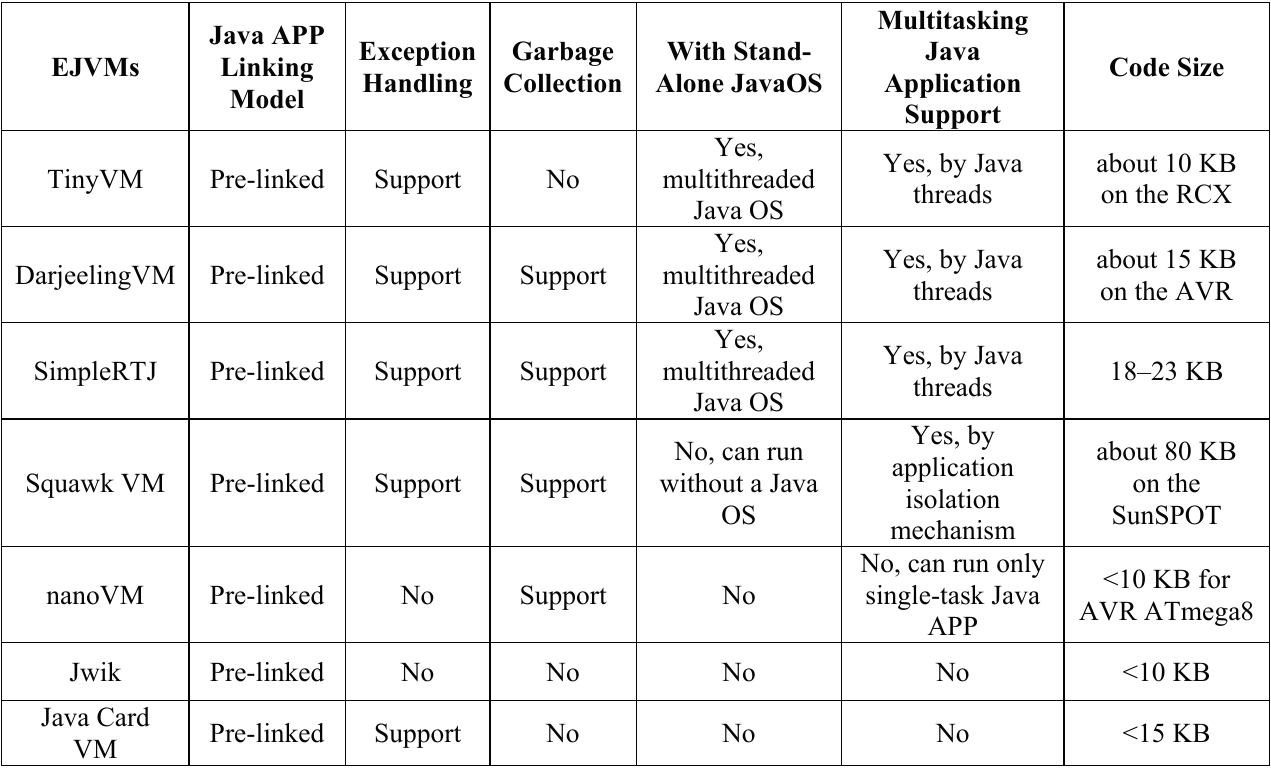
Table 5. Feature comparison of the current popular